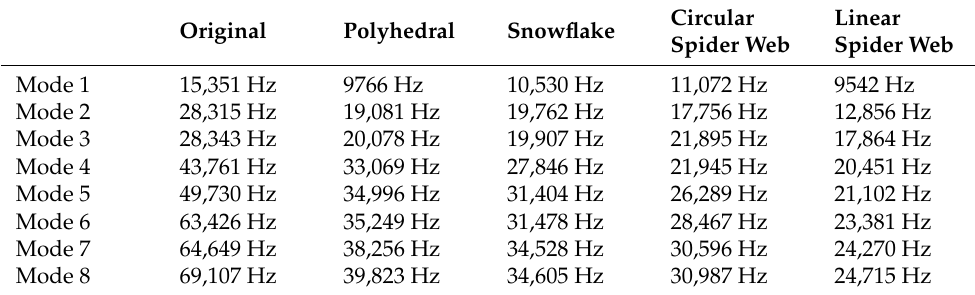
Table 7. Modal frequencies simulation